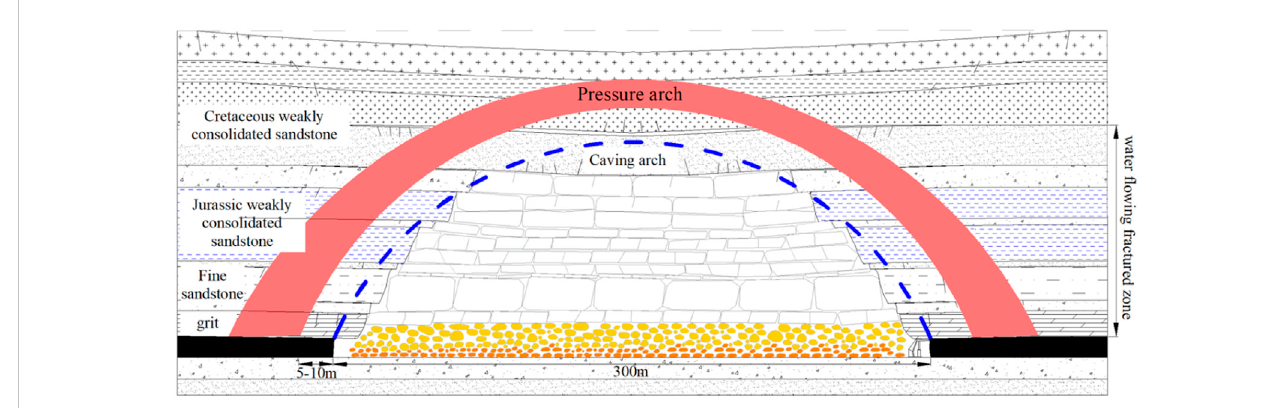
FIGURE 3 Occurrence characteristics and fracture morphology of overlying strata in Hongqinghe Coal Mine.